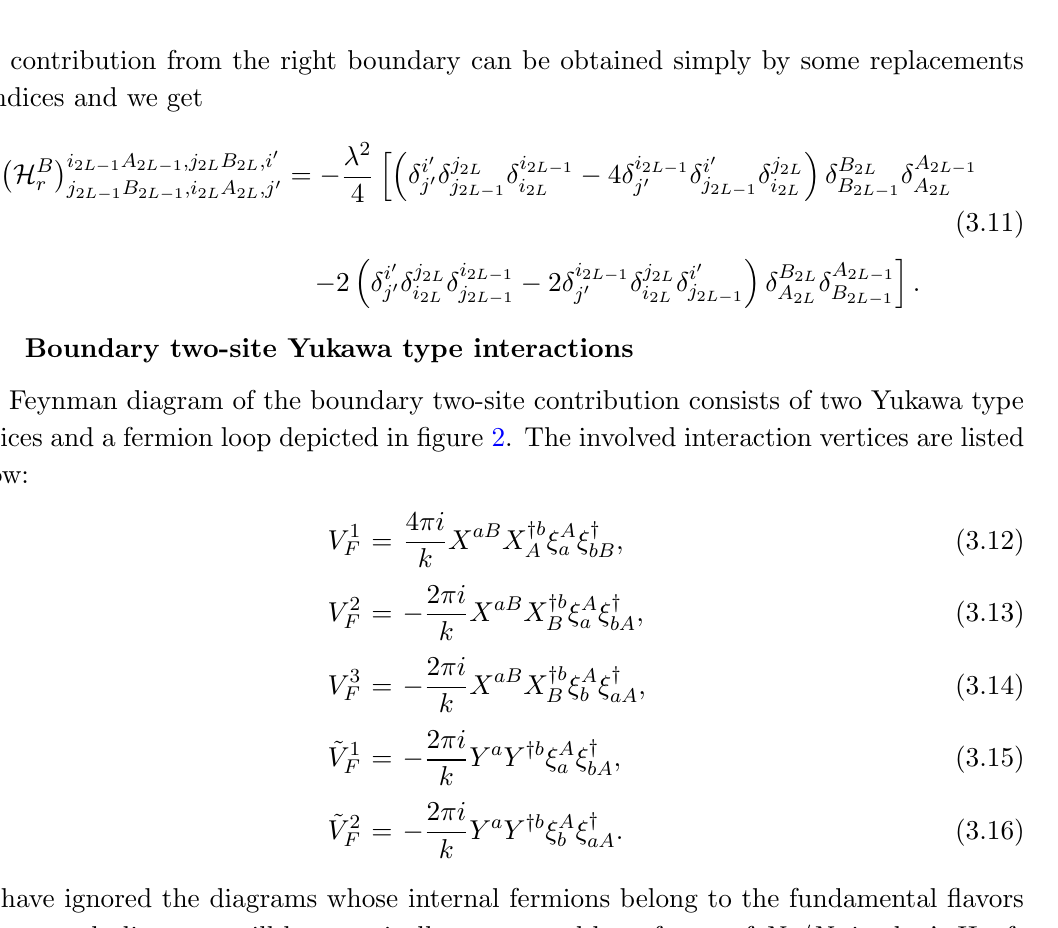
Figure 2 . The contribution of Yukawa interactions on the left